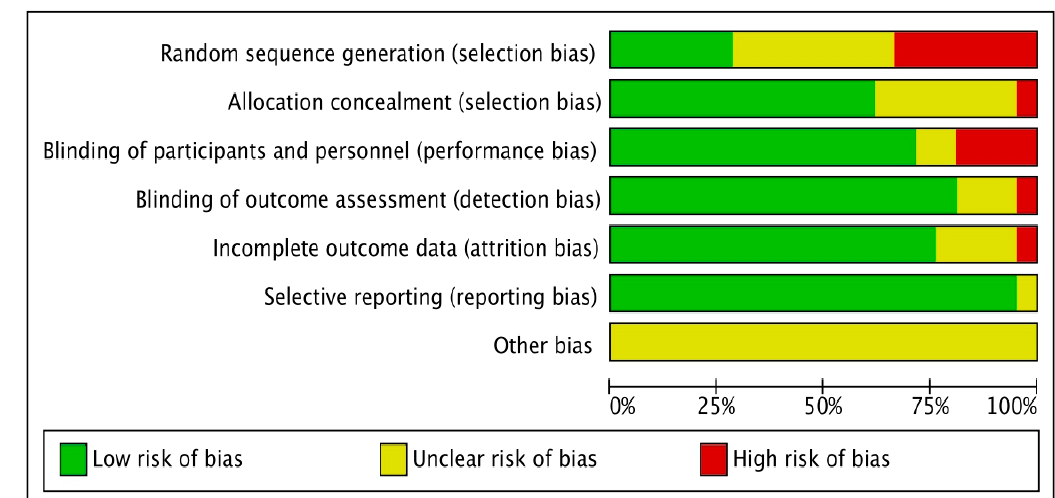
Figure 3. Risk of bias items are presented as percentages across all included studies.